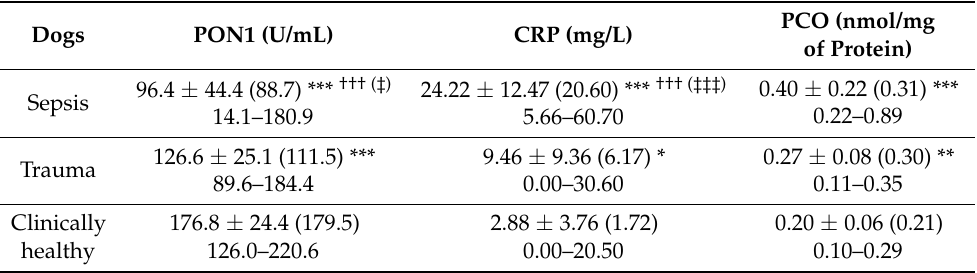
Table 1. Mean ± SD, median (between parenthesis) and min-max range of PCO, CRP and PON1 in dogs with sepsis, trauma and clinically healthy dogs.